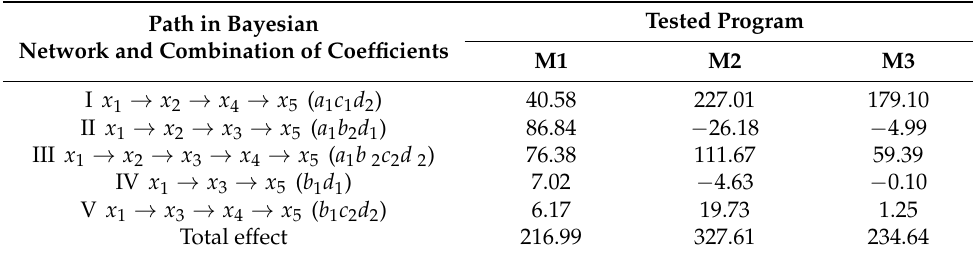
Table 8. Assessing the total effect of interventions on labor productivity for different programs. Path in Bayesian Network and Combination of